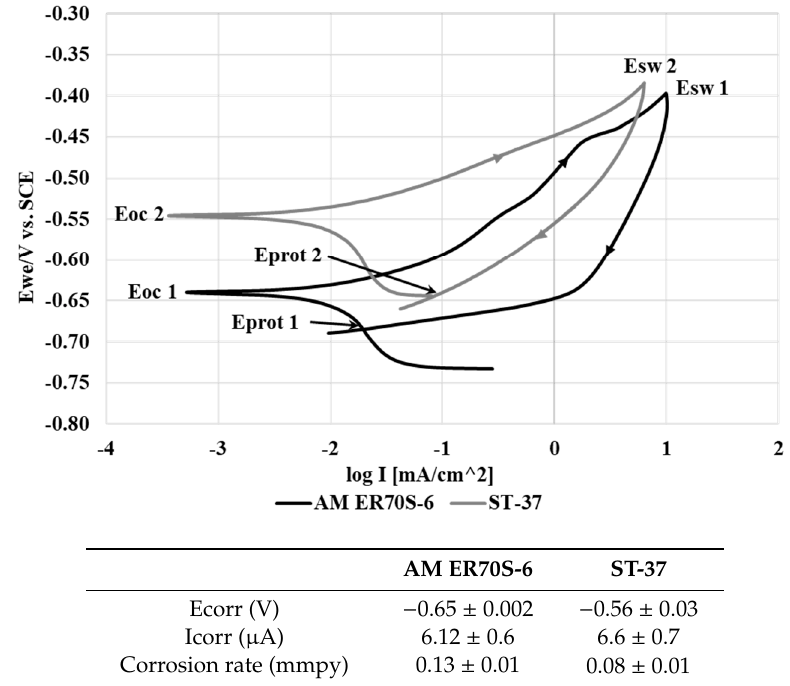
Figure 4. Cyclic potentiodynamic polarization analysis of additively manufactured ER70S-6 alloy and reference ST-37 alloys in 3.5% NaCl solution.